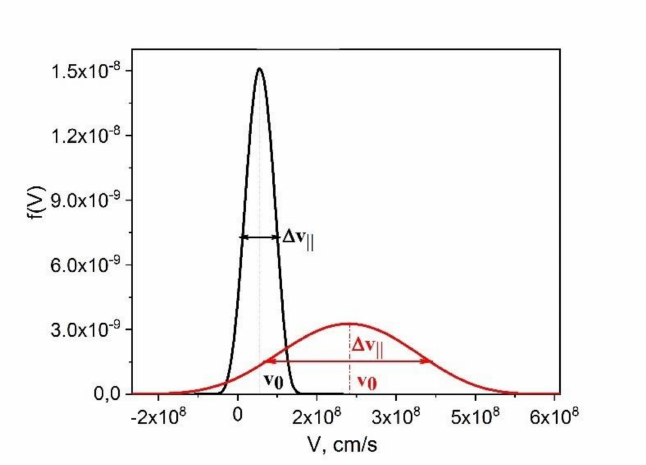
Figure 2. One-dimensional electron velocity distribution functions (EVDF) along the polarization of two-color laser field with fundamental wavelengths 800 nm (black curve) and 3900 nm (red curve). Here ν 0 , ∆ ν || are the mean velocity and velocity dispersion correspondingly: ν = 4.2 · 10 7 , ∆ ν || = 5.3 · 10 7 cm / s for 800 nm; ν 0 3900 nm. Distribution functions are normalized to